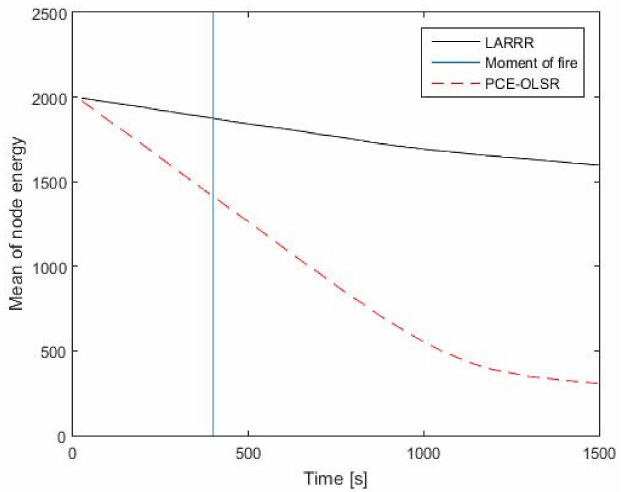
Figure 12. EC results between LARRR and PCE-OLSR.